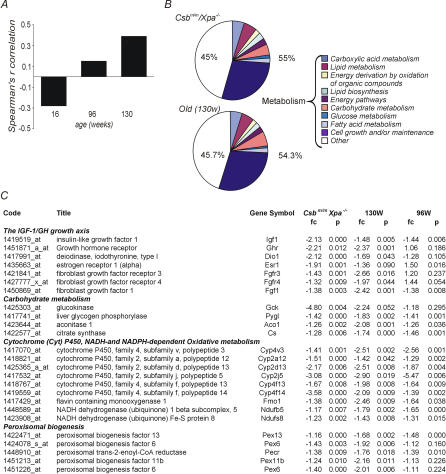
Transcriptome Similarities between Csbm/m/Xpa−/− and Naturally Aged Mice(A) Spearman's r correlation of 16-, 96- and 130-wk-old mice with 15-d-old Csbm/m/Xpa−/− mice, where −1.0 is a perfect negative (inverse) correlation, 0.0 is no correlation, and +1.0 is a perfect positive correlation.(B) Similarities between significantly overrepresented biological processes. Note that in both Csbm/m/Xpa−/− and naturally aged mice, transcriptional changes were mostly associated with metabolic processes.(C) Correlation in significant expression changes of genes associated with the GH/IGF1 axis and oxidative metabolism in the livers of Csbm/m/Xpa−/− and naturally aged (96- and 130-wk-old) mice. An extensive overview is listed in Tables S3 and S4.